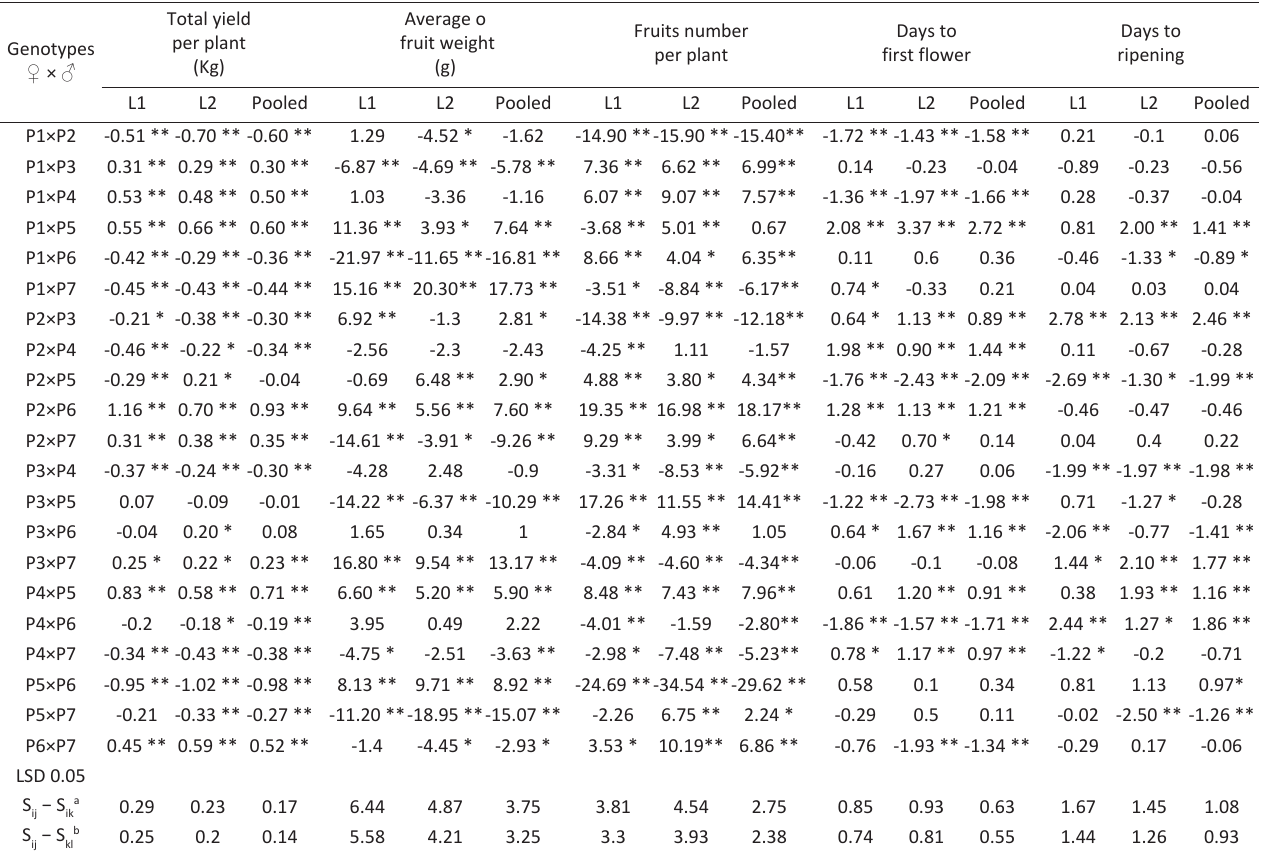
Table 7 - Specific combining ability (SCA) effects of F1 hybrids for yield, yield components and earliness in a 7×7 diallel cross over two light